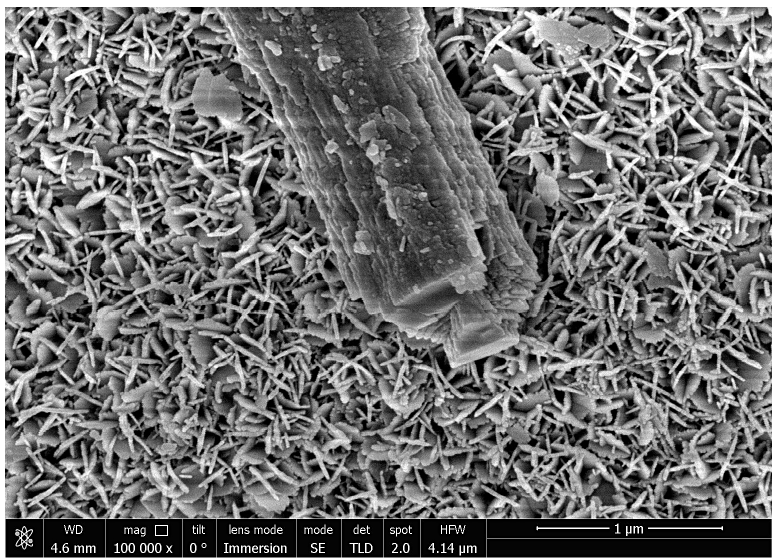
Figure 6. Micrograph of the reaction product layer for the sample thermally treated at 300 °C. The results of X ray diffraction analysis are given in Figure 7.